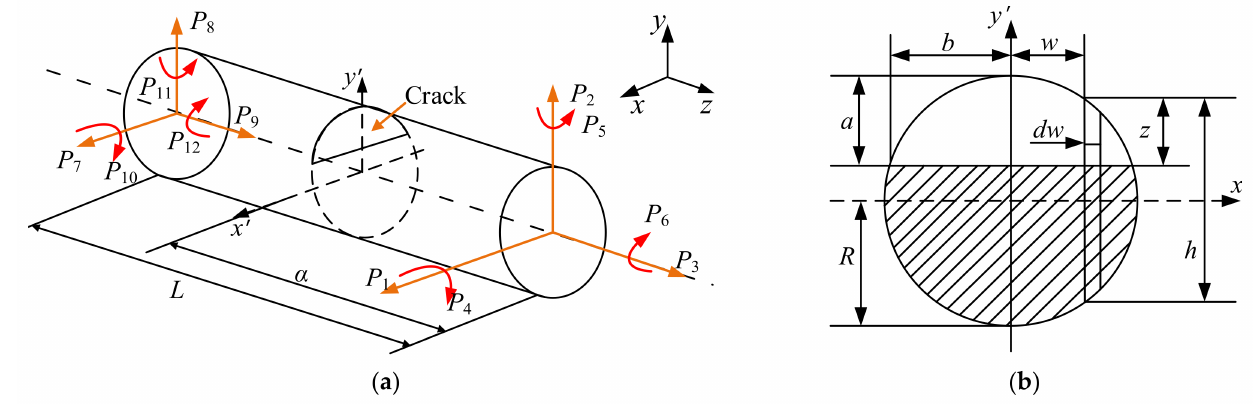
Figure 2. The cracked shaft element. ( a ) A diagram of the cracked shaft element. ( b ) The cross- sectional view of the